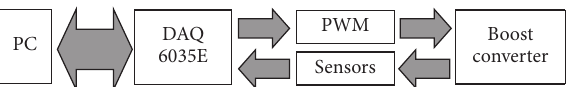
Figure 4: Block diagram on the representation of the experimental platform. The data acquisition board DAQ6035E is used for data transferring from the computer to the external circuits and vice versa.